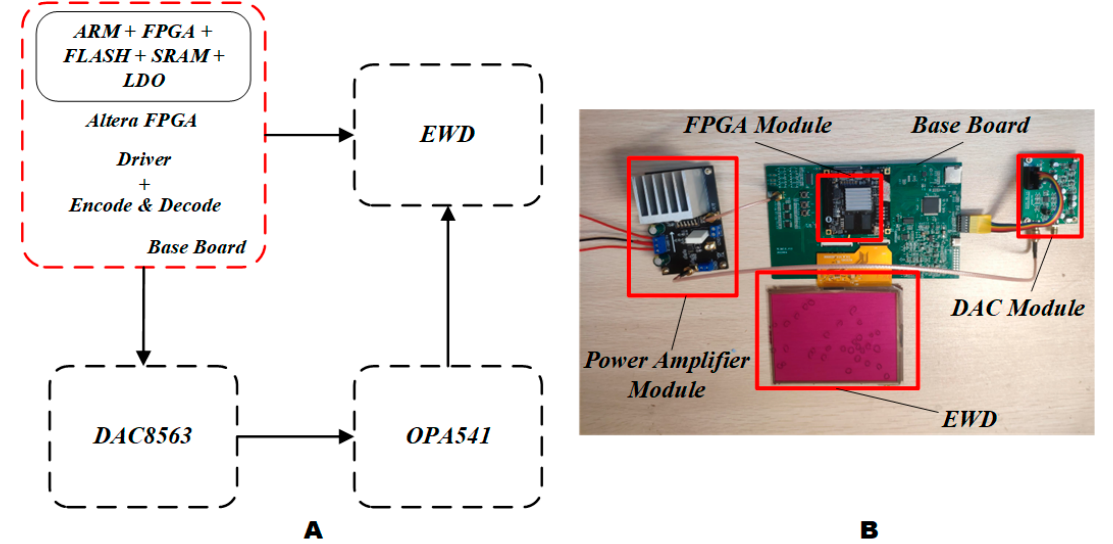
Figure 4. EWD driving waveform experiment system. ( A ) EWD driving waveform experiment sys- tem structure diagram. ( B ) EWD driving waveform experiment system diagram. system structure diagram. ( B ) EWD driving waveform experiment system diagram.